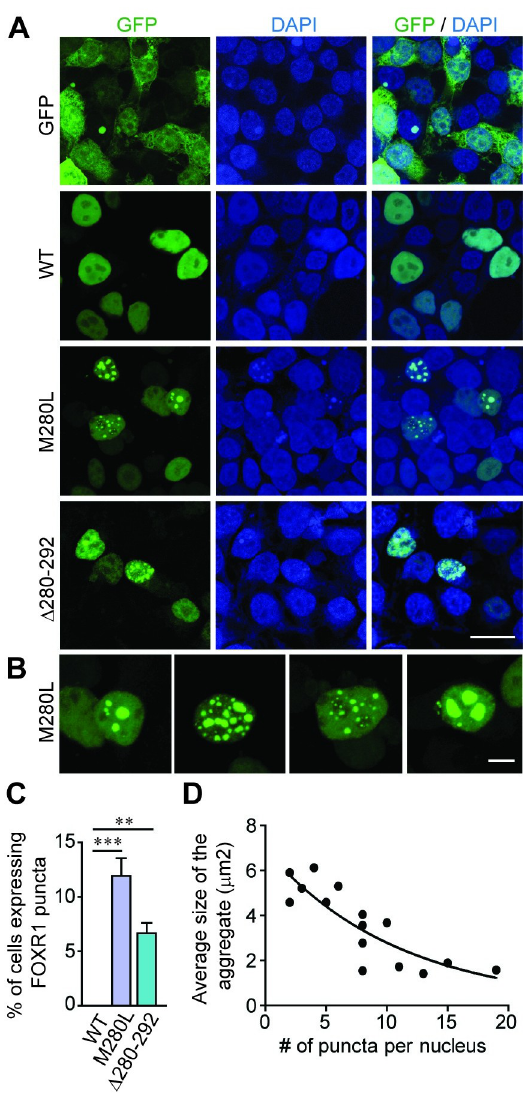
Fig 3. The M280L variant induces nuclear puncta phenotype. (A) Fluorescence images of HEK293T cells transfected with GFP or GFP-tagged human FOXR1 WT, M280L or Δ 280–292mutants. DAPI (blue) served as a nuclear marker. Scale bar = 20 μ m. (B) Fluorescence images of HEK293T cells transfected with GFP-tagged M280L mutant showing a range of nuclear puncta phenotypes.Scale bar = 5 μ m. (C) Quantitative analysis of the percentage of cells showing FOXR1 puncta phenotype. One-way ANOVA Tukey’s multiple comparisons test (n = 3 independent experiments, �� p = 0.0048, ��� p = 0.0002). (D) Correlation analysis of the average size of the aggregate to the number of puncta per nucleus. and batch effects (S3A Fig). We plotted a heat map of the log (-2) fold change for all the differen- tially-expressed genes (DEGs) and delineated five coherent clusters (Fig 4A). Differential gene expression analysis between GFP and FOXR1 WT transfected cells identified 2644 DEGs of which 1315 (49.7%) were upregulated and 1329 (50.3%) were downregulated transcripts (Figs 4A and S3B). To determine the effect of FOXR1 M280L, we compared WT and M280L, and identified 735 DEGs of which 561 (76.3%) were upregulated and 174 (23.7%) were downregu- lated (S3B Fig). We paid special attention to those transcripts whose levels showed a 2-fold increase in FOXR1 WT and a decrease in M280L as delineated in cluster E (Fig 4B).